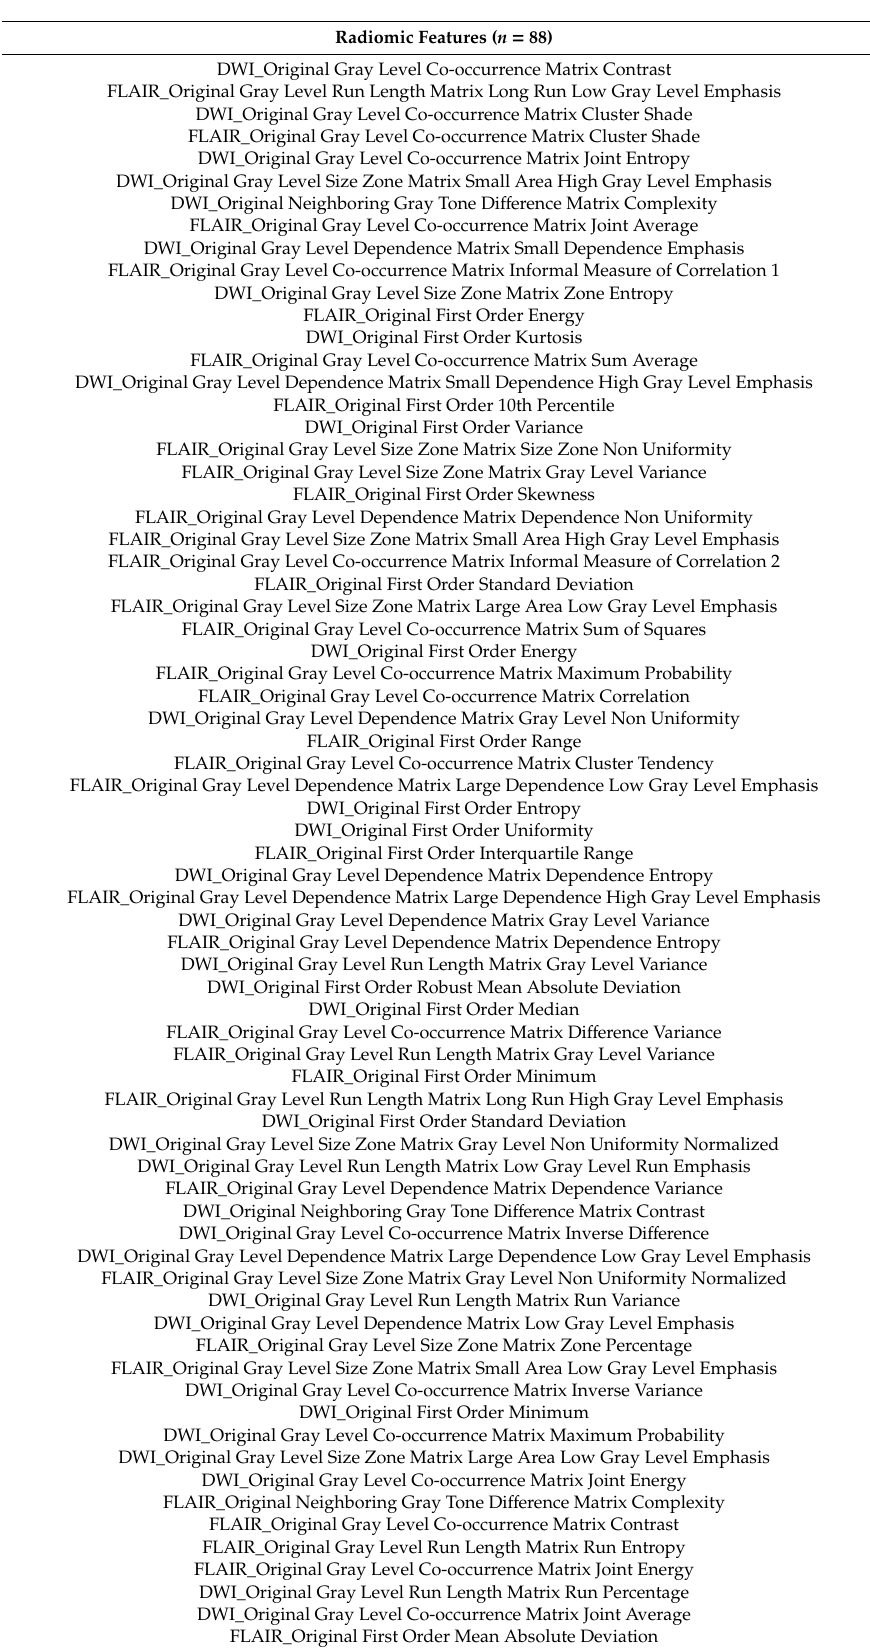
Table A3. Cont. Radiomic Features ( n =